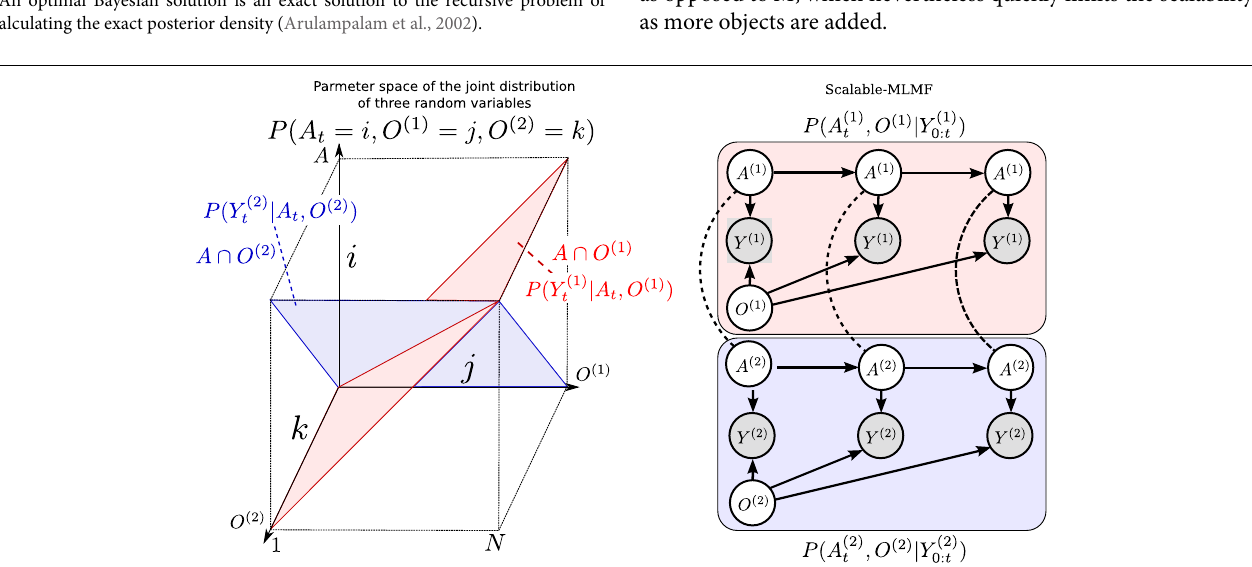
Frontiers in Robotics and AI |